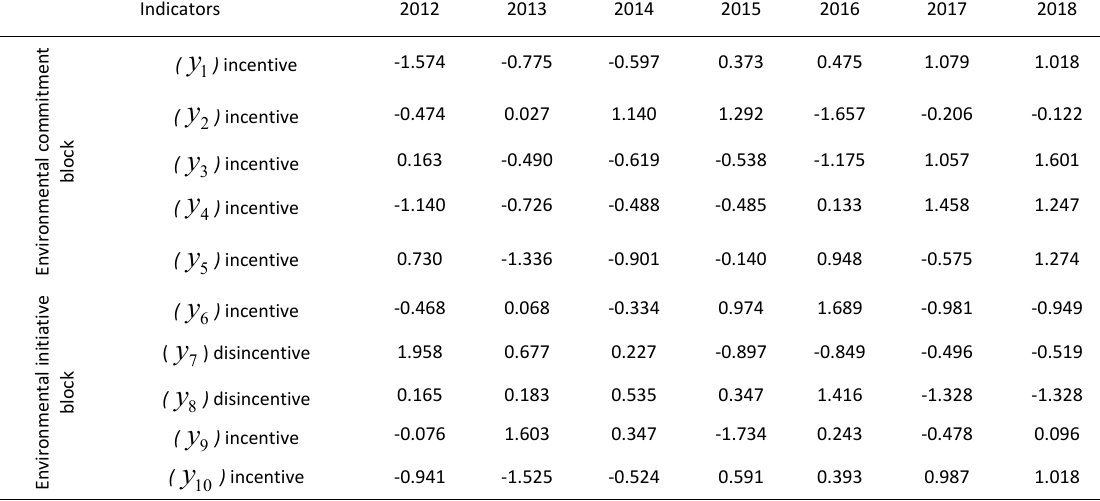
Table 7: Standardized matrix for the assessment of environmental responsibility